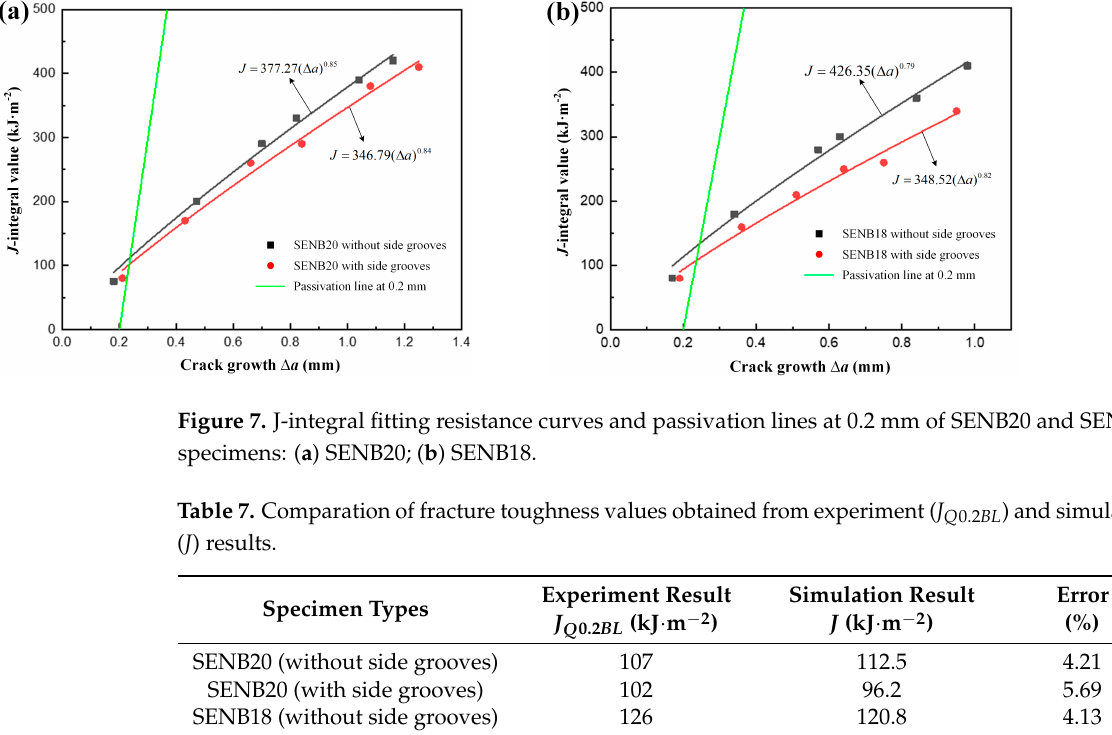
Table 7. Comparation of fracture toughness values obtained from experiment ( J Q 0.2 BL ) and simulation ( J ) results.